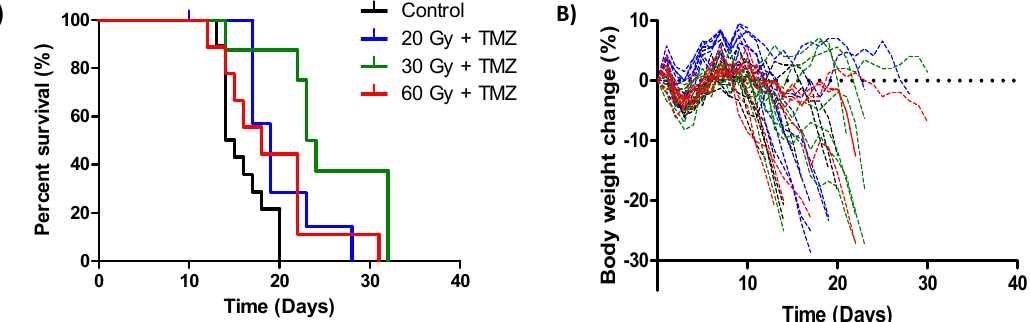
Figure 3. Therapeutic efficacy of standard-of-care (SOC) therapy using a targeted radiation strategy ( A ) Kaplan–Meier survival curves of animals following orthotopic F98 GBM implantation and a single dose of targeted radiation (as specified) with concomitant temozolomide (TMZ). Survival endpoint was defined as the time an animal left the experiment for humane reasons. n ≥ 8 animals per treatment group. ( B ) Body weight loss of the treatment groups over time following surgical implantation of the tumor. Percentage body weight change relative to starting body weight was determined.